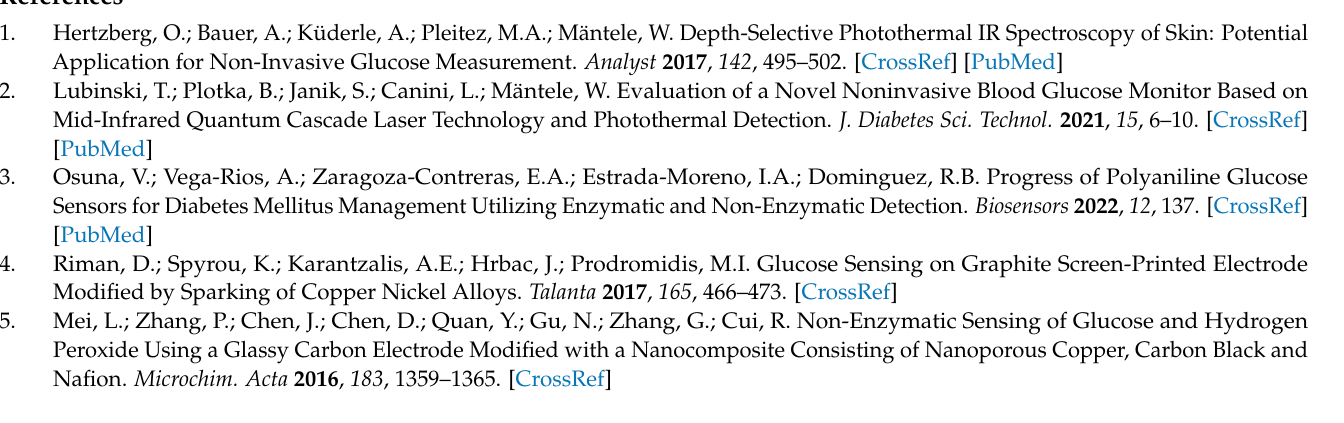
Figure S3 EDX spectra recorded from the backside of the AAO/PANI/Ag